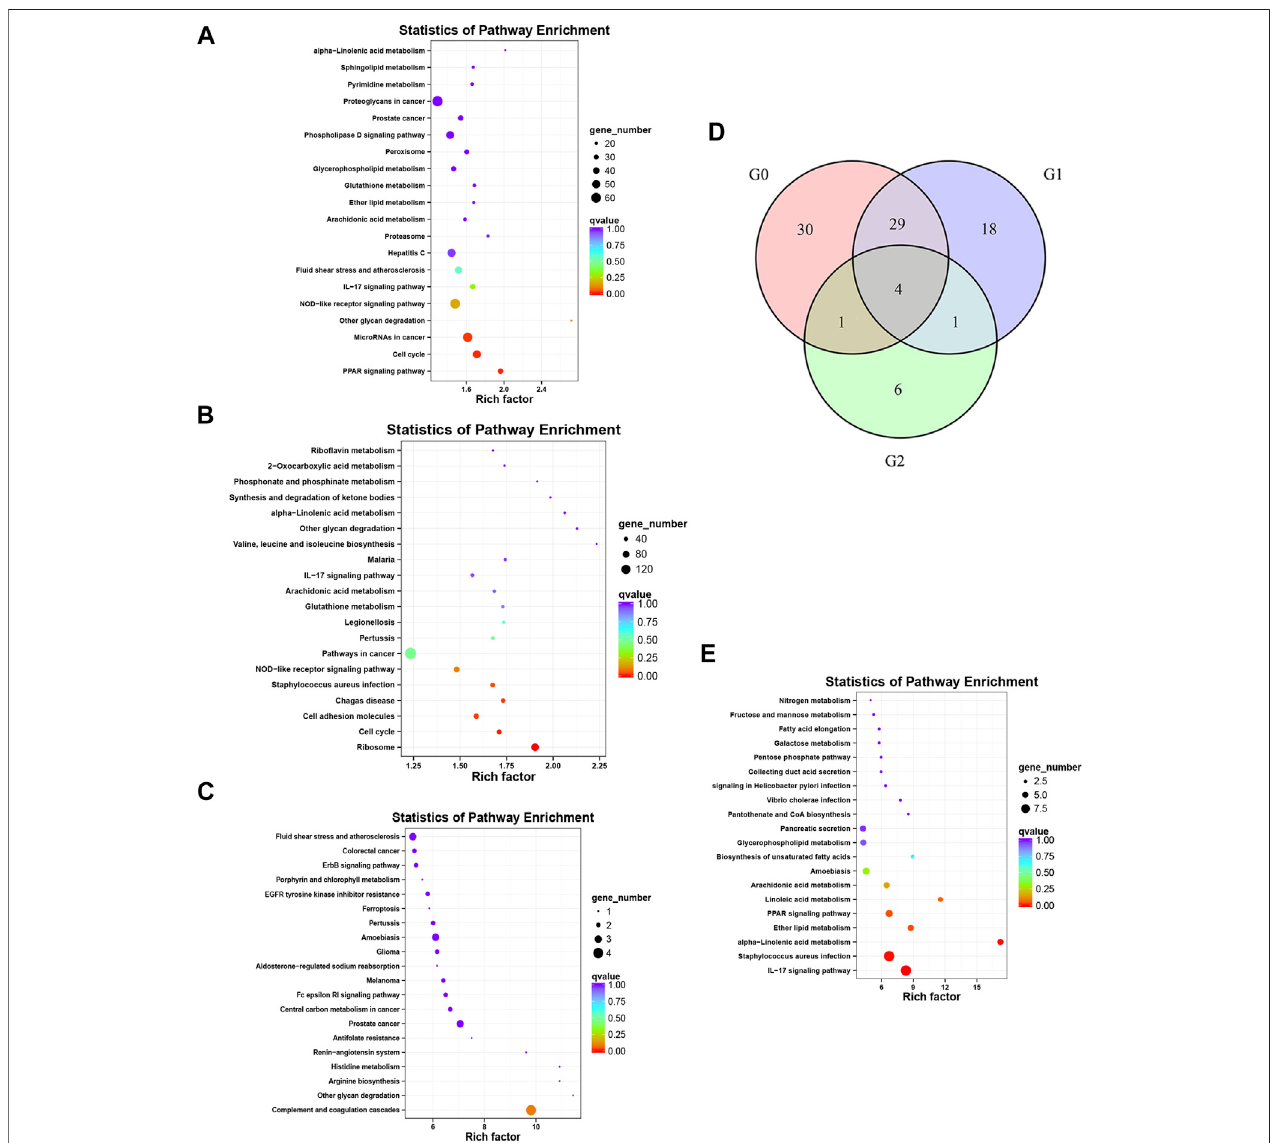
FIGURE 4 | KEGG analysis. Enrichment and distribution map of KEGG pathways of DEGs. Each circle in the map represents a KEGG pathway. The ordinate representsthenameofthepathway,andtheabscissa(enrichmentfactor)representstheratiooftheproportionofgenesannotatedtoapathwayamongtheDEGstothe proportion of genes annotated to apathway among all genes. (A) KEGG pathwaysfor the DEGs before vs. after oxymatrinetreatment. (B) KEGG pathway for the DEGs in patients with psoriasis vs. normal controls. (C) KEGG pathway for the DEGs in oxymatrine-treated patients vs. normal controls. (D) Venn map. G0 indicates the numberofpathwaysinthebeforevs.afteroxymatrinetreatmentcomparison.G1indicatesthenumberofpathwaysintheaftertreatmentvs.normalcontrolcomparison. G2 indicates the number of pathways in the before treatment vs. normal control comparison. (E) KEGG pathways of 205 genes.